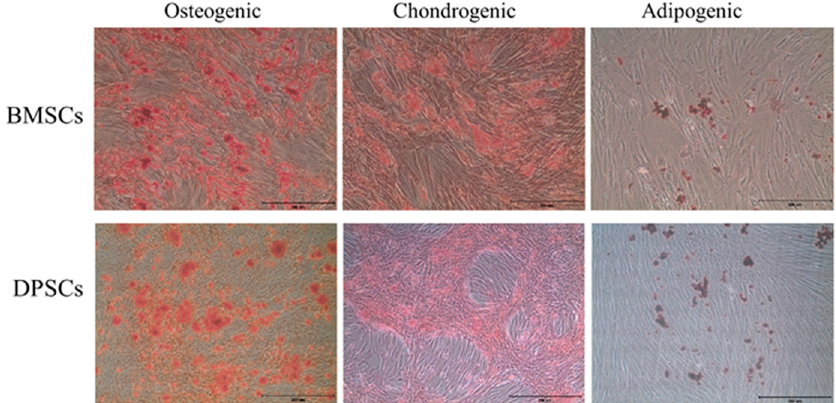
Figure 3. Images showing in vitro trilineage differentiation of cultured BMSCs and DPSCs. The trilineage differentiation capacities of the BMSCs and DPSCs were confirmed by alizarin red for extracellular calcium, safranin O for extracellular cartilage, and oil red O for intracellular lipid accumulation. Scale bars = 100 μ m.